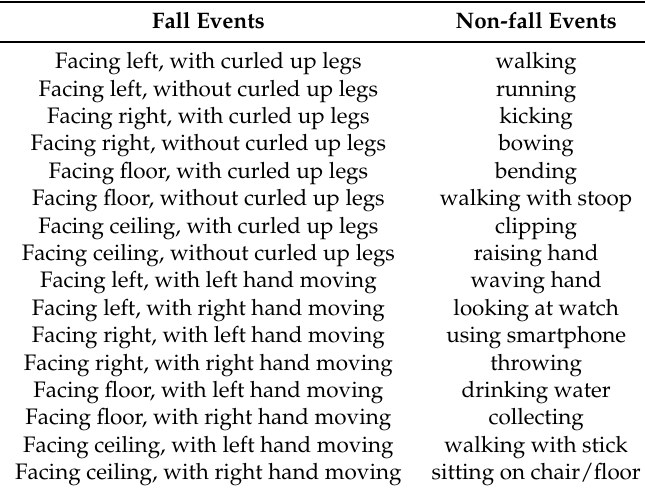
Table 1. Evaluation scenarios in data set.